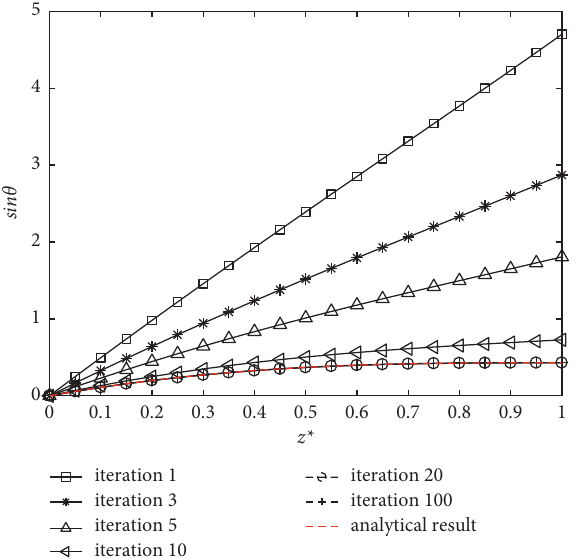
Figure 3: Evolution of sin θ as a function of z ∗ for different iterations.